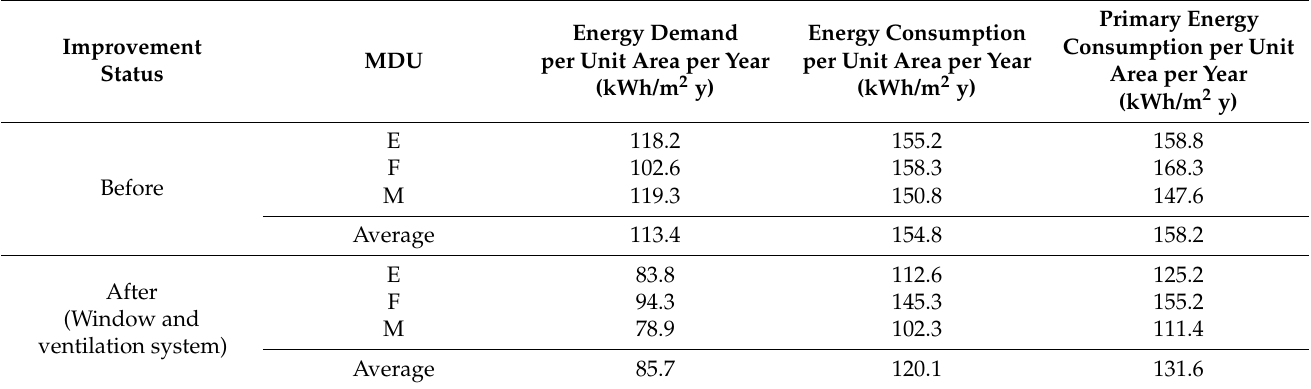
Figure 12. Improvement rate (%) of primary energy consumption per area per year and energy de- mand per unit area, after simultaneous application of window and ventilation system improvements. Table 8. Changes in energy demand, energy consumption and primary energy consumption of E, F, and M MDU complexes before and after window and ventilation system improvement.